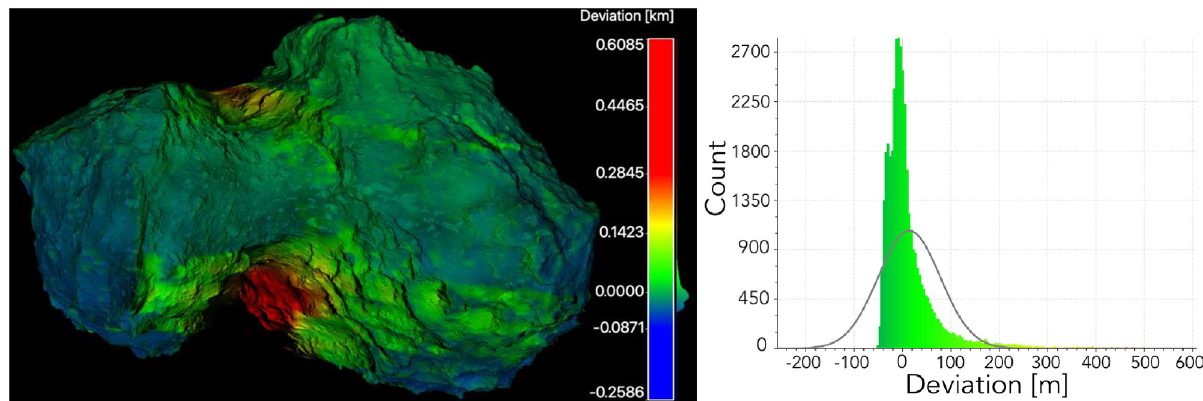
Fig 15. Deviation analysis of the reconstructed partial mesh and input 3-D model for image synthesis. Visualisation of deviation (left); errors and Gaussian distribution (right).